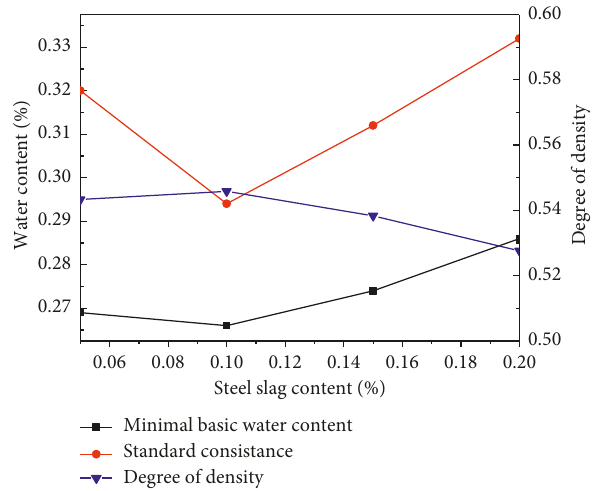
Figure 3: Steel slag content effect on standard consistence minimal water requirement and stacking density.